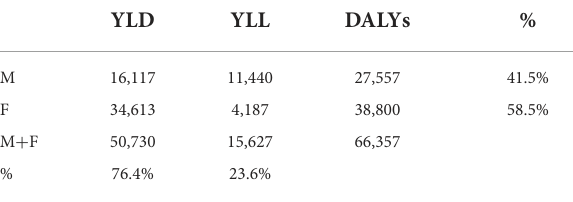
TABLE 5 Disability-adjusted life years attributable to TRD and MDSR,